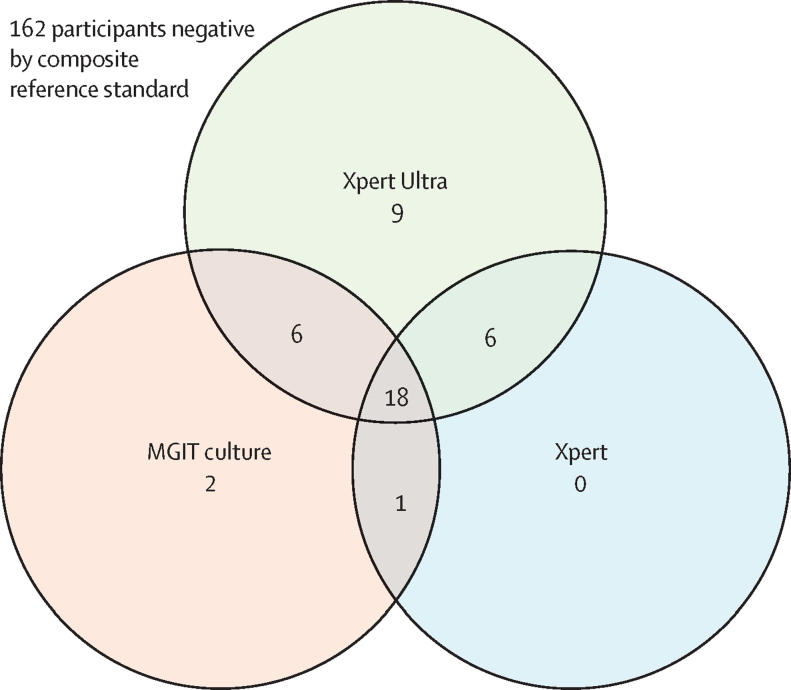
Venn diagram of positive diagnostic tests in the composite microbiological reference standardThe Venn diagram displays 42 participants with microbiologically confirmed tuberculous meningitis by either Xpert, Xpert Ultra, or MGIT culture. Xpert=Xpert MTB/RIF. MGIT=mycobacterial growth indicator tube.